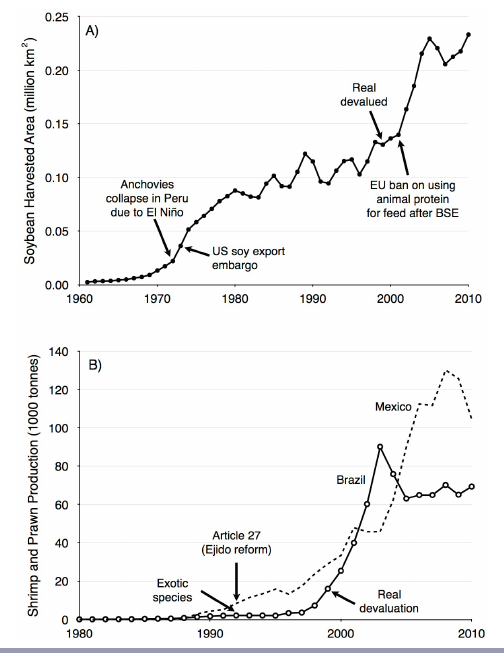
Fig. 3 . Two case studies of land-use regime shifts. (A) The expansion of soybeans in Brazil since 1960; and (B) the growth of aquaculture production in Latin America since 1980. These cases illustrate important regime shifts in the development of these land uses, as well as the significance of events in causing these